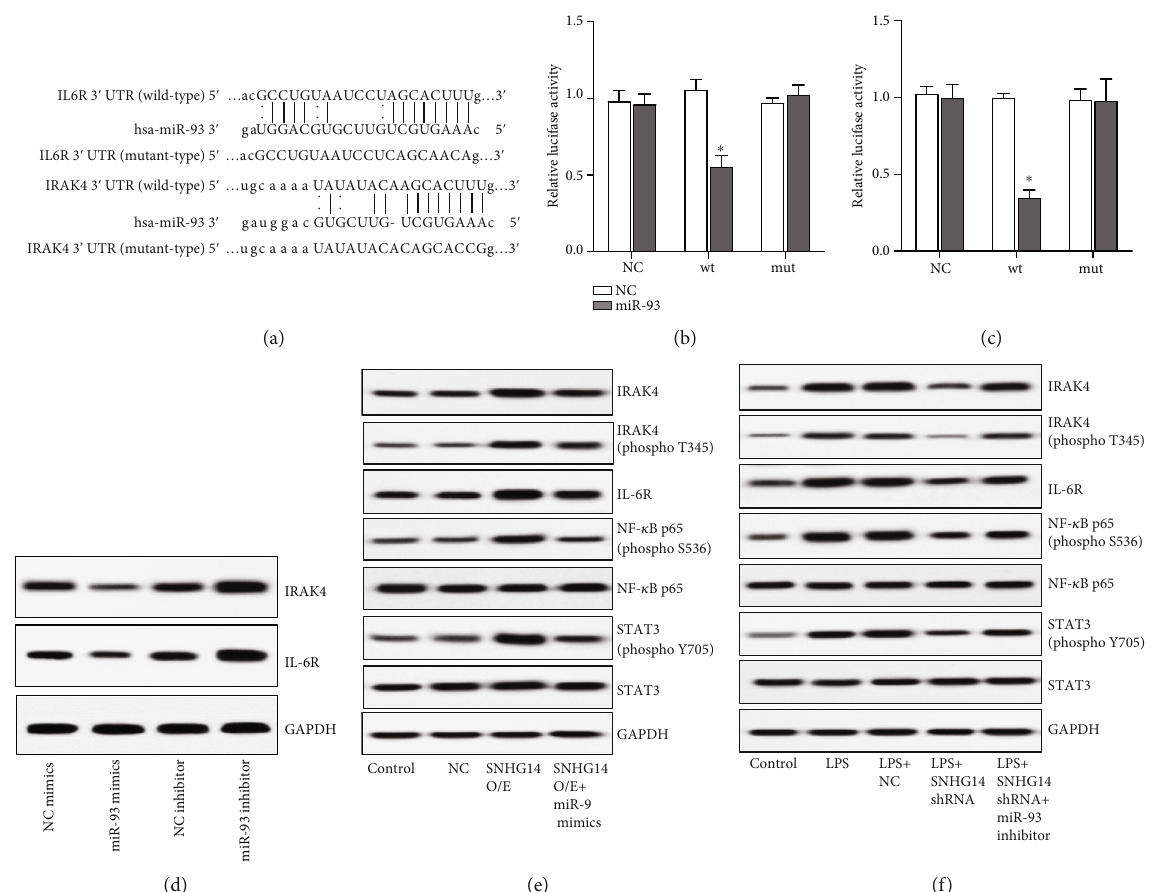
Figure 4: SNHG14/miR-93 activates NF- κ B and STAT3 signaling through mediating IRAK4 and IL-6R. (a) Predicted binding site of miR-93 in IRAK4 and IL-6R 3 ′ UTR. (b, c) Luciferase assays showed that overexpressing miR-93 decreased the activity of luciferase reporter containing wild-type IRAK4 or IL-6R 3 ′ UTR. (d) IRAK4 and IL-6R protein levels detected by western blot after HK-2 cells were transfected with miR-93 mimics or inhibitor. (e, f) HK-2 cells were transfected with SNHG14 overexpression plasmids and miR-93 mimics, and LPS-induced HK-2 cells were transfected with SNHG14 shRNAs and miR-93 inhibitor; relative proteins in IRAK4/NF-kb and IL-6R/STAT3 signaling were analyzed using western blot. Data were shown as mean ± SD , ∗ P < 0 : 05